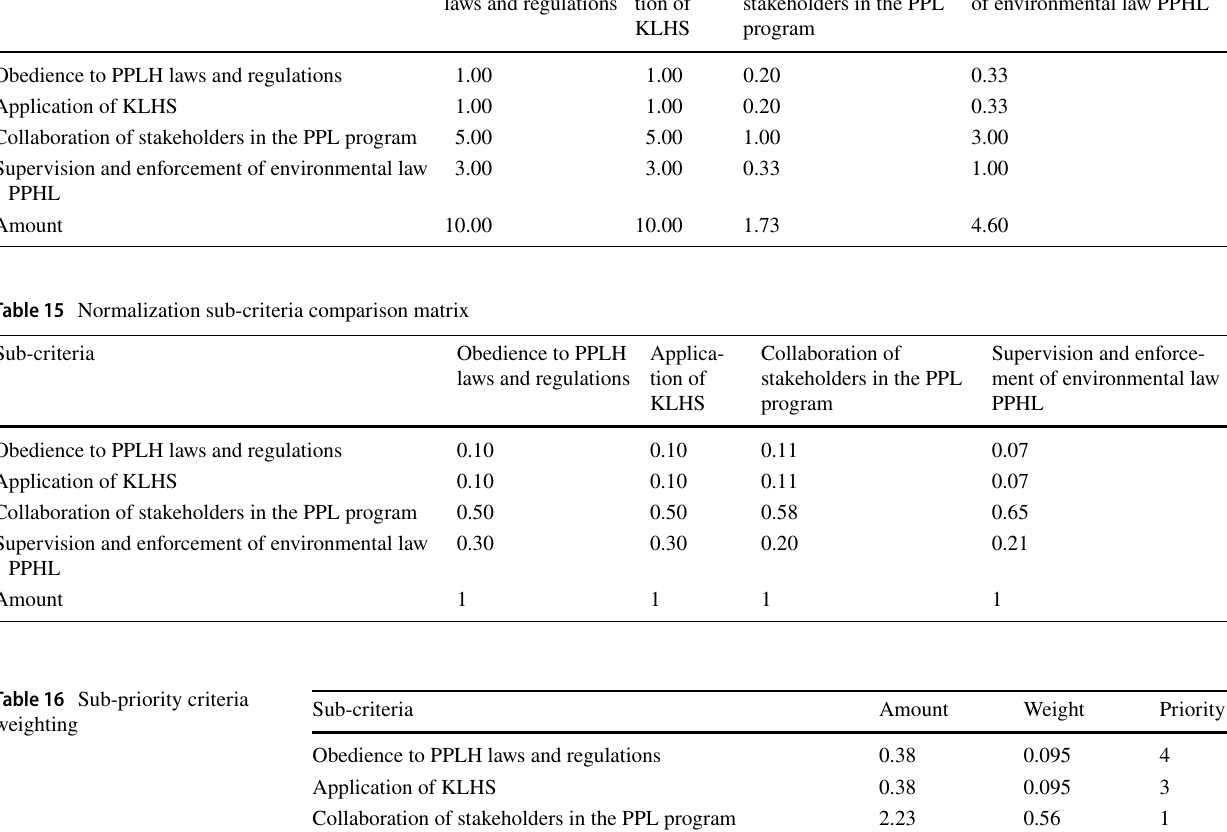
Table 14 Matrix comparison of sub-criteria Sub-criteria